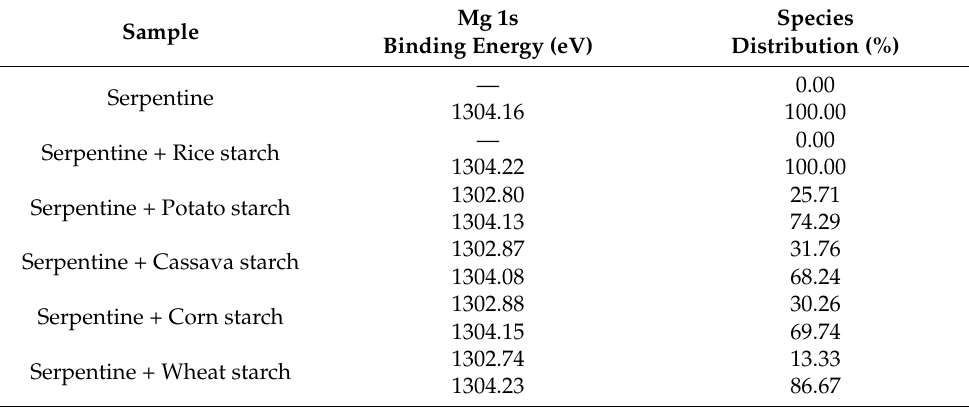
Table 3. Quantification of Mg 1s species in serpentine and depressant-treated serpentine samples.